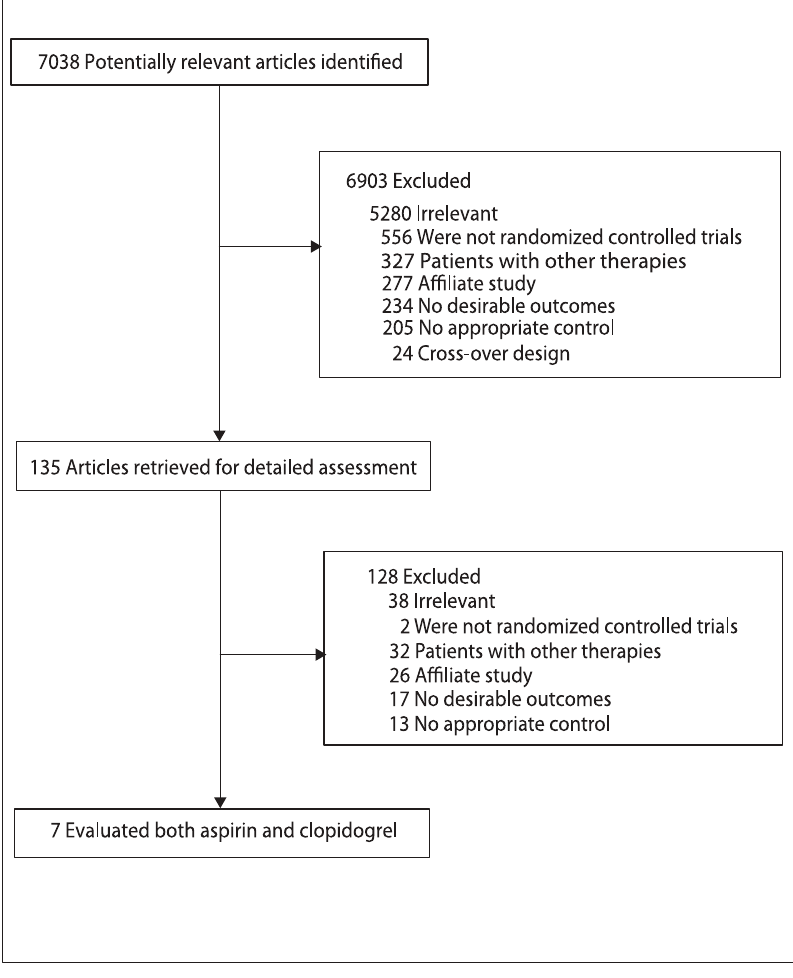
Figure 1. Flow diagram of the literature search and trials selection process.